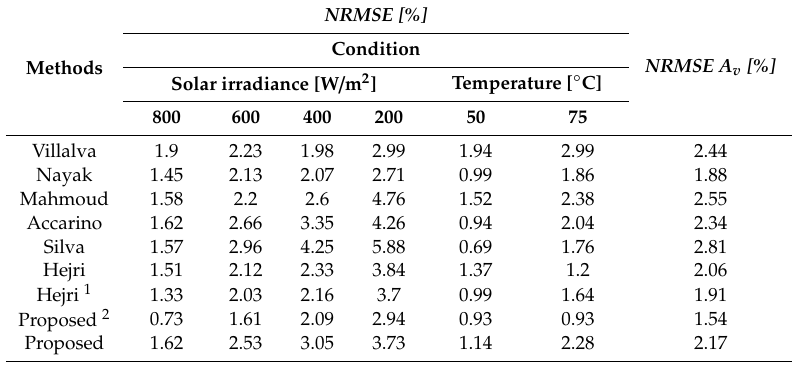
1 Curve fitting method. 2 Datasheet table value.